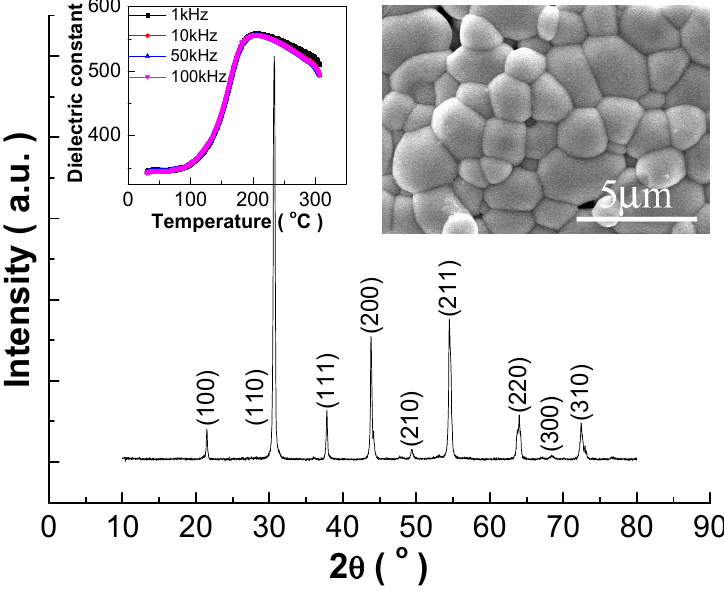
Figure 4. XRD pattern of the 0.25 mol% Y 2 O 3 -doped PSLZSnT ceramics. Inset shows temperature dependence of dielectric constant measured at several frequencies upon the cooling process and SEM image of the free surface after thermal etching at 850 ° C for 30 min.